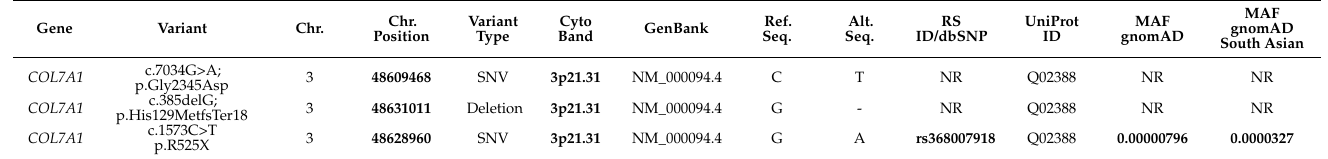
Table 1. Information on COL7A1